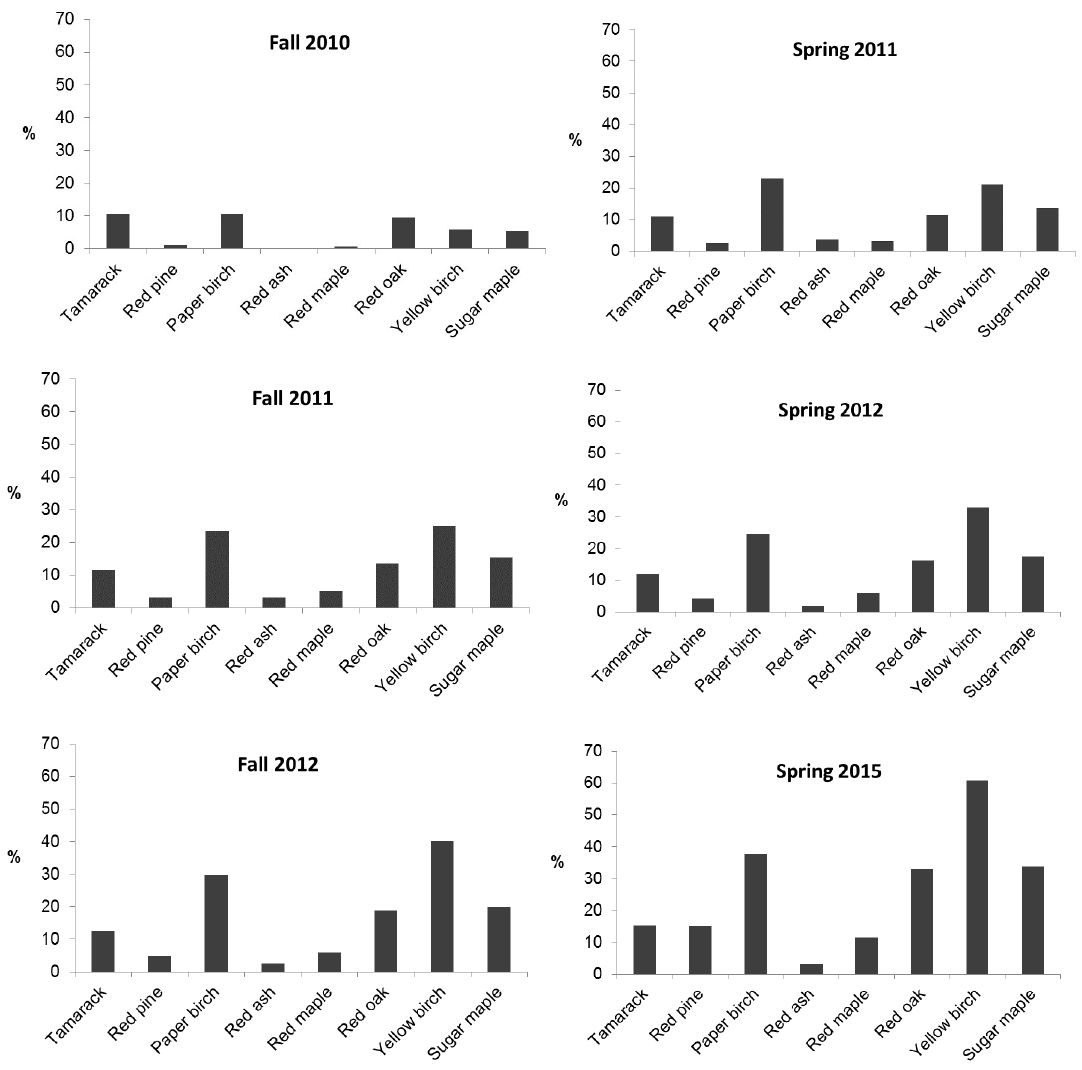
Figure 1. Rates of seedling mortality (all treatments combined) as a function of tree species in fall 2010, spring 2011, fall 2011, spring 2012, fall 2012, and spring 2015.